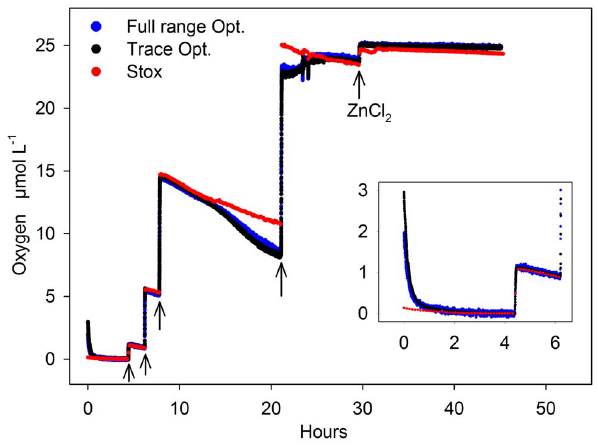
Figure 3. Experiment 1: Comparing optodes (trace and full range) and STOX sensor. Degassed water was successively enriched with oxygen by adding known volumes of air saturated water (arrows). Consumption rates were calculated after each addition from the O 2 decrease over time (see Figure 4 A–C). ZnCl 2 was added after 30 hours to stop biological activity. The insert shows the initial adaptation of